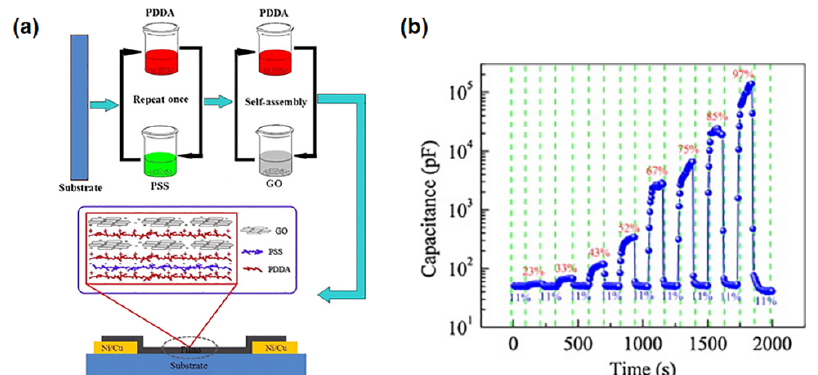
Figure 6. ( a ) Schematic representation showing the layer-by-layer fabrication of GO/PDDA nano- composite films. ( b ) Variation of the capacitance value for the GO/PDDA sensors upon switching the relative humidity levels in the range of 11–97%. The exposure/recovery cycles were performed with an exposure interval of 125 s followed by a recovery interval of 125 s at 11% RH. Reproduced with permission from Zhang et al., Sens. Actuators B Chem.; published by Elsevier, 2014 [29]. A quartz-crystal microbalance (QCM) resonator comprised of a GO/tin dioxide/pol-